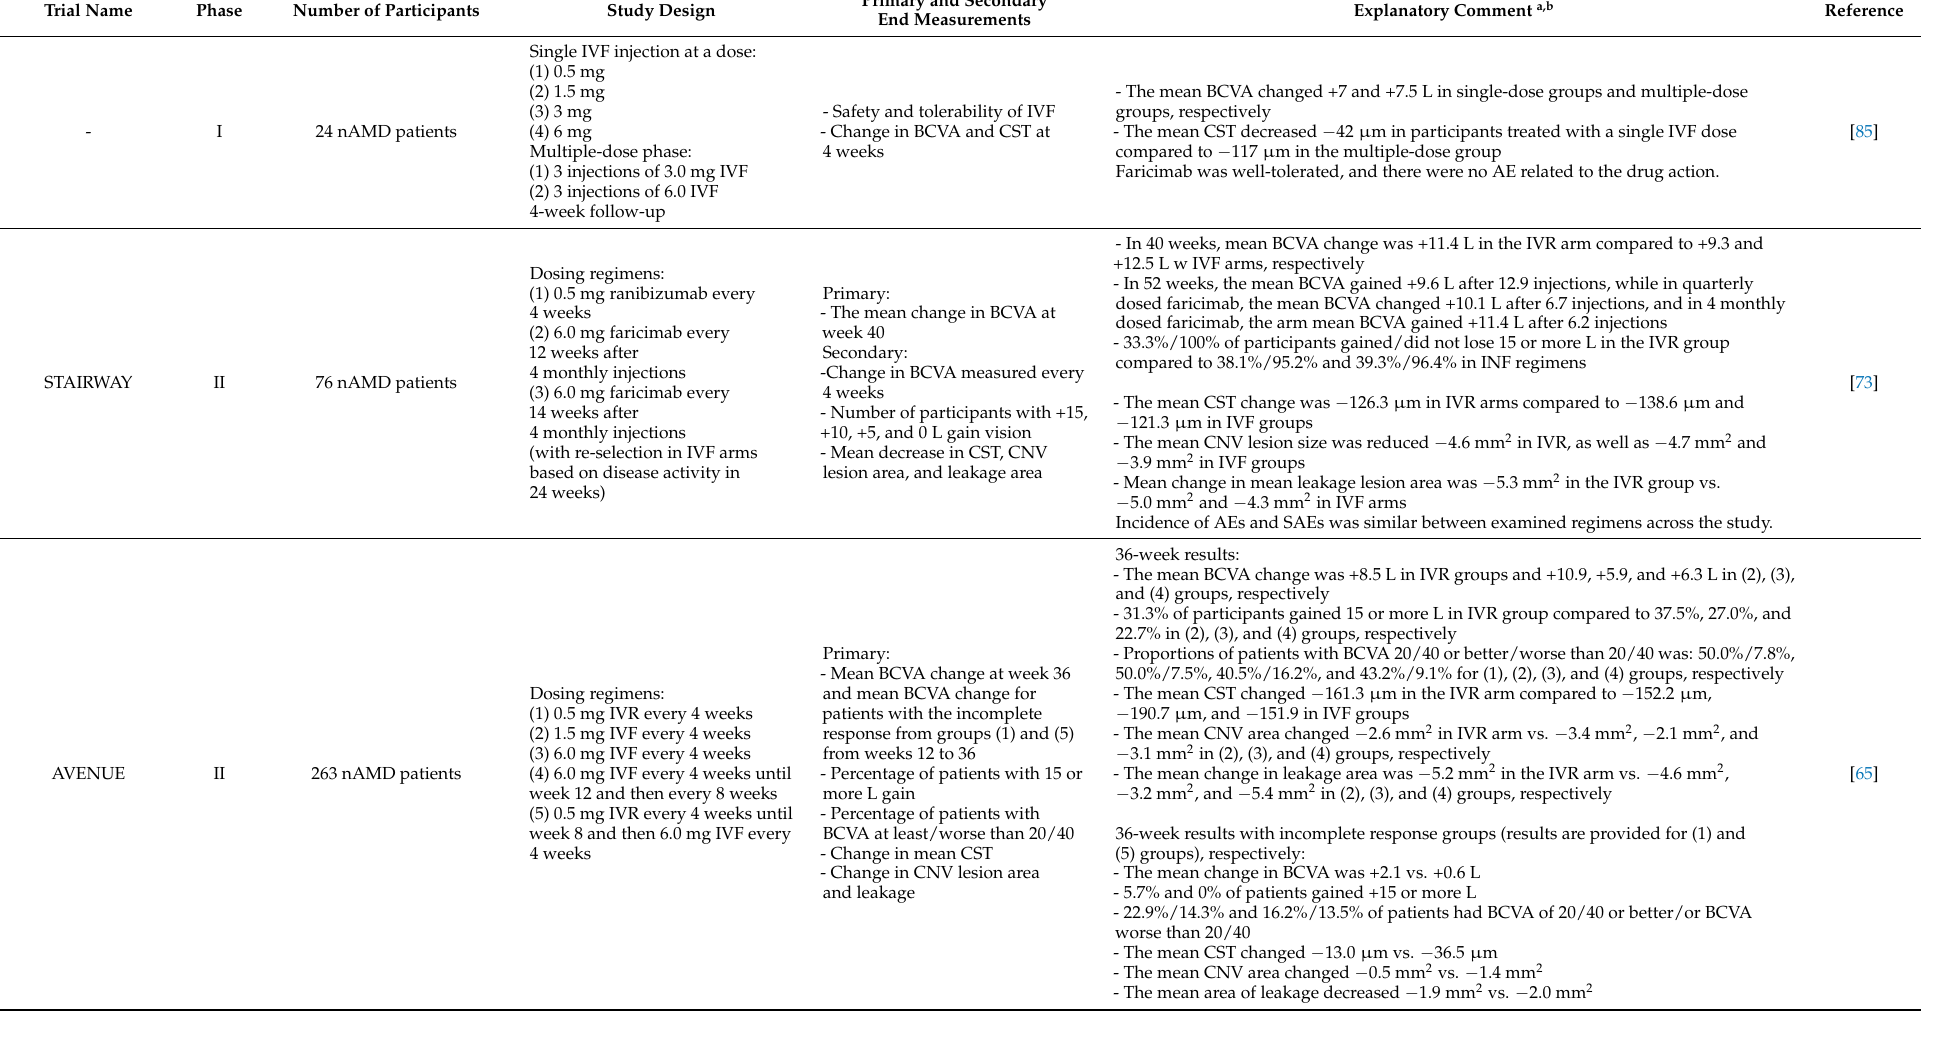
Table 4. Summary of clinical trials assessing the use of faricimab in the treatment of